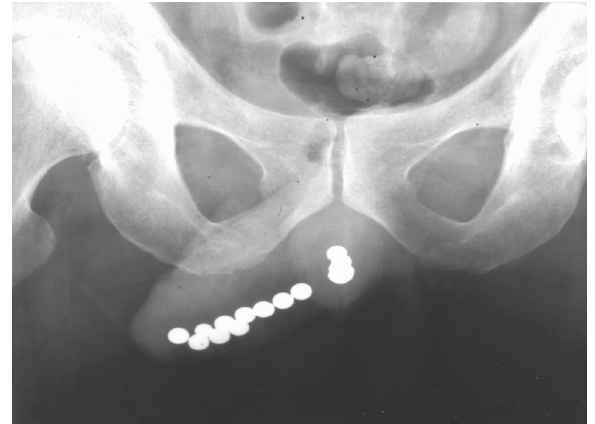
Figure 1 – X-ray of the pelvis showed multiple metallic objects approximately 1 cm in diameter in the anterior and posterior